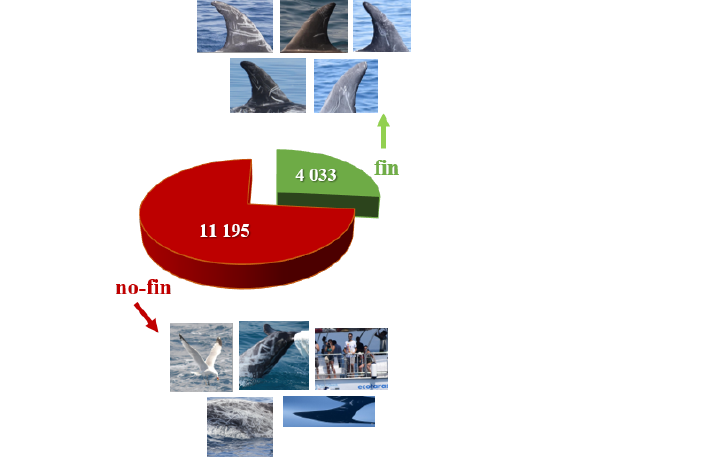
Figure 11. CNN training data along with examples of input images belonging to the two categories fin and